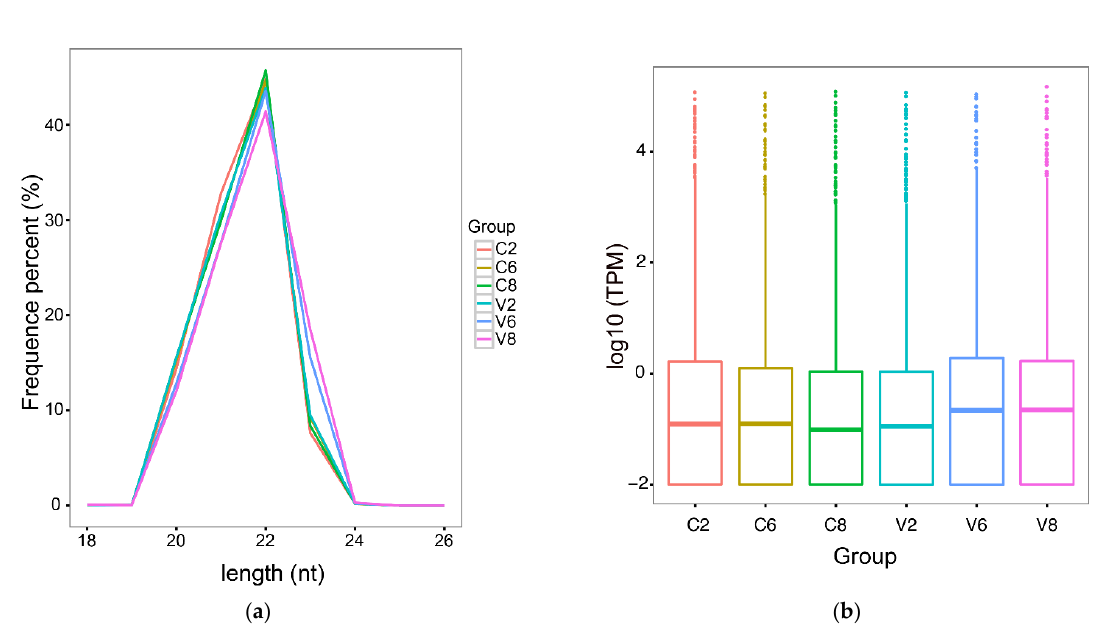
Figure 1. MicroRNA (miRNA) sequencing data analysis in the spleen of flounder. ( a ) The length distribution of the miRNAs in each group. “C2”, “C6”, and “C8” indicate control fish groups at 2, 6, or 8 days post infection (dpi), respectively; “V2”, “V6”, and “V8” indicate megalocytivirus-infected fish groups at 2, 6, or 8 dpi, respectively; ( b ) Boxplot profiling the expression levels of the miRNAs in each group at 2, 6, and 8 dpi. TPM, transcripts per million.